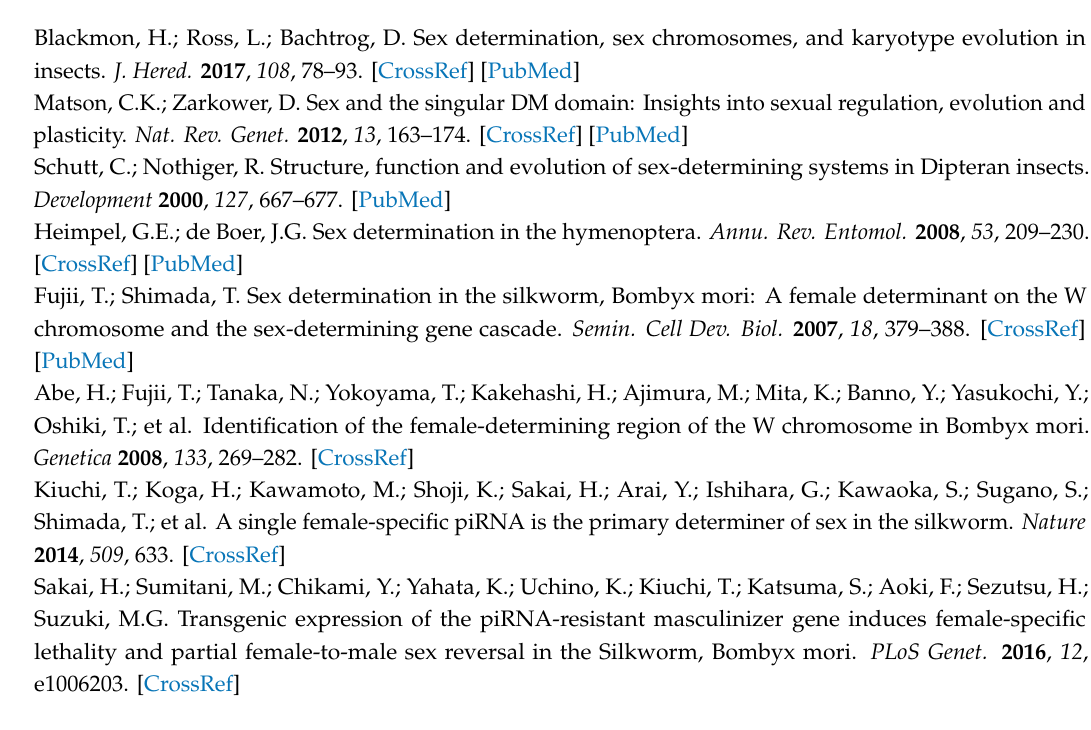
Figure S1: PCR analysis of Masc transcripts in fifth instar larvae, Figure S2: Expression levels of Masc-S and Bmexu in the female during the fifth instar stage, Table S1: List of primer sequences used in this study, Table S2: Result of RNA-protein pull-down and LC-MS / MS